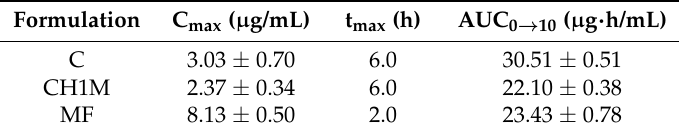
Table 5. Pharmacokinetic parameters of metformin hydrochloride plasma concentration after single oral administration of non cross-linked microparticles formulation (C), cross-linked microparticles formulation (CH1M) and commercially available tablet with metformin hydrochloride (MF) in an amount corresponding to the 100 mg/kg b.wt. ( n =